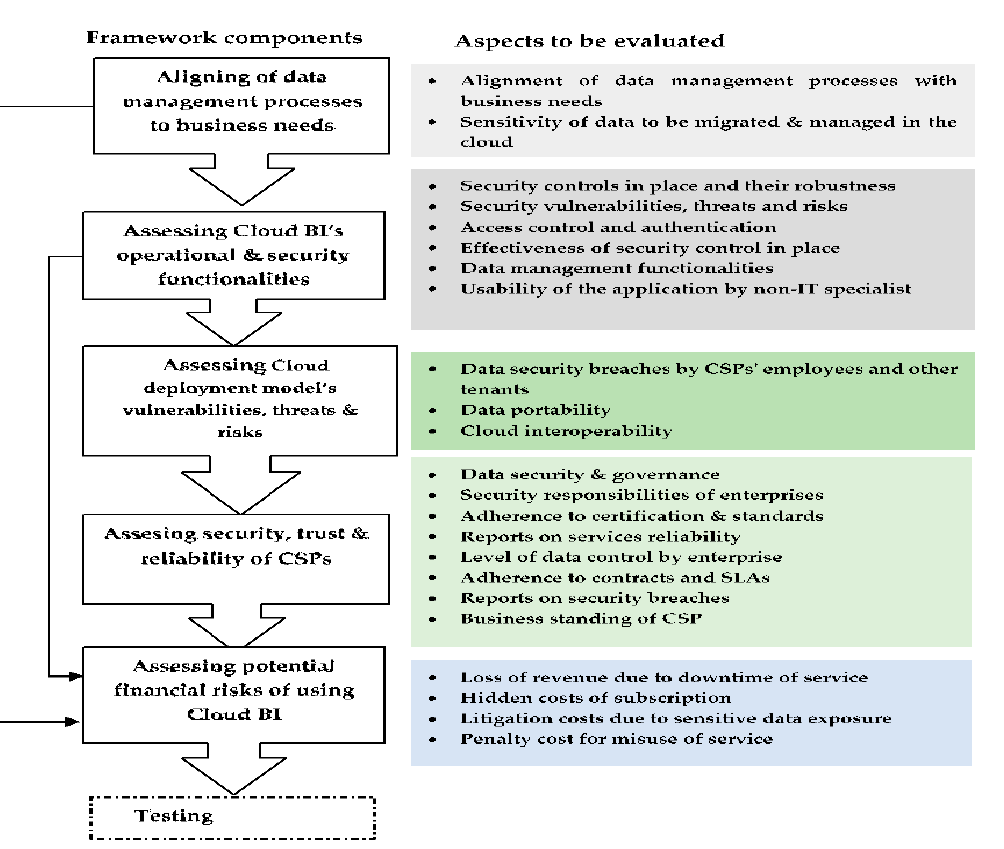
Figure 7. A conceptualised security evaluation framework for Cloud BI by SMEs.